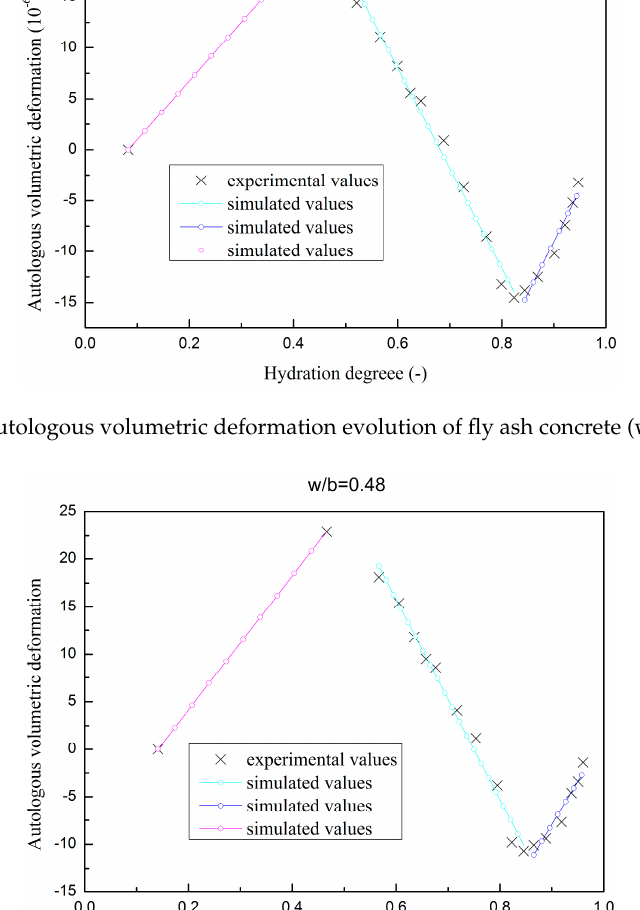
Figure 6. Autologous volumetric deformation evolution of fly ash concrete (w/b = 0.48).